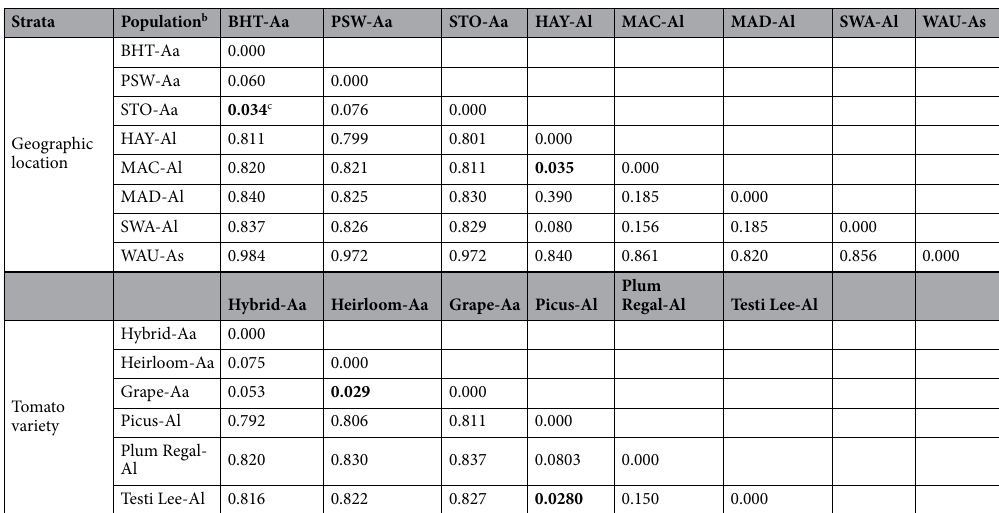
Table 2. Pairwise comparison of population differentiation Jost’s D a between populations of Alternaria alternata (Aa), A. linariae (Al), and A. solani (As) collected from different geographic locations and tomato and potato varieties in North Carolina (NC) and Wisconsin analyzed with 220 single nucleotide polymorphisms (SNPs) from 10 microsatellite loci. a Jost’s D was computed between pairs of the population 82 . The statistical significance of Jost’s D was calculated by a randomization test. b Populations of Alternaria spp. were defined in the methods. c Bold values indicate populations where the null hypothesis was not rejected ( P < 0.05) indicating no differentiation between populations.